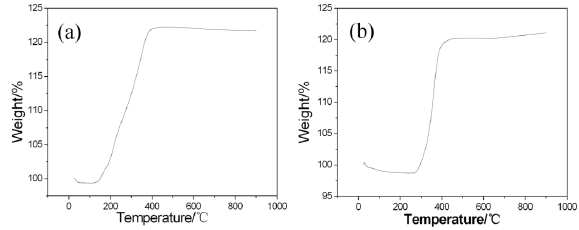
Figure 8: TG curves of Cu (a) and Ni-coated Cu (b) powders.